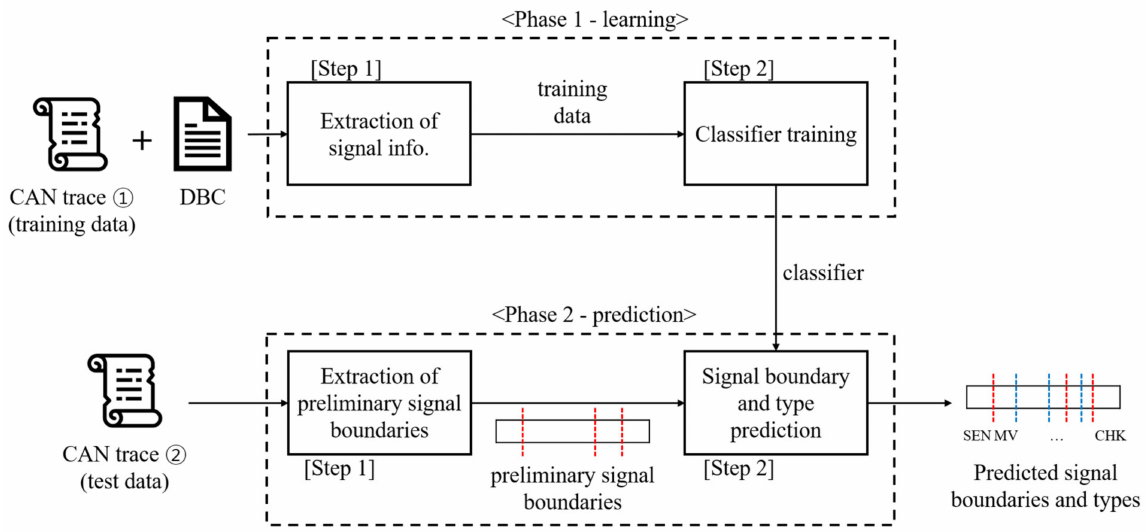
Figure 1. Overall process of